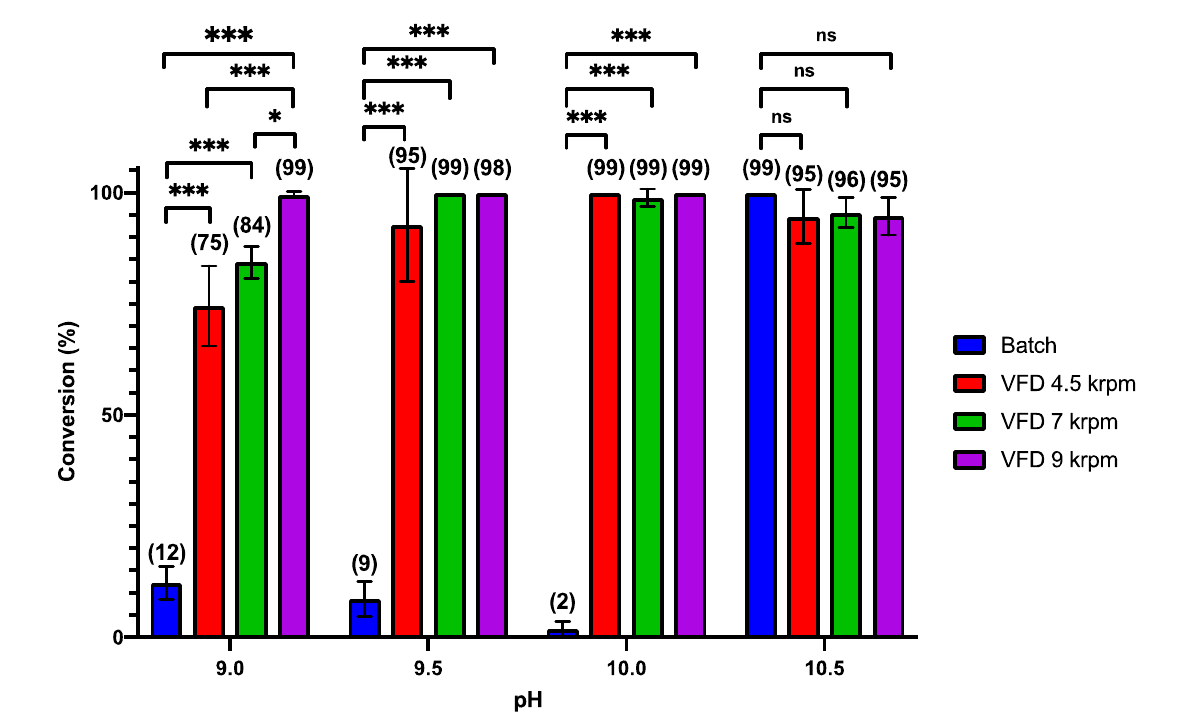
Figure 4. Oxidative sulfitolysis of oxytocin. Comparisons between batch versus three VFD operational speeds, 4.5, 7, and 9 k rpm, performed in carbonate buffered at pH of 9, 9.5, 10, and 10.5; conversions were determined using HPLC with percent conversion determined by comparing areas under the curve for reduced and sulfitolysed oxytocin. Significance is reported as ns (not significant), * ( p < 0.01), ** ( p < 0.001), or *** ( p < 0.0001).